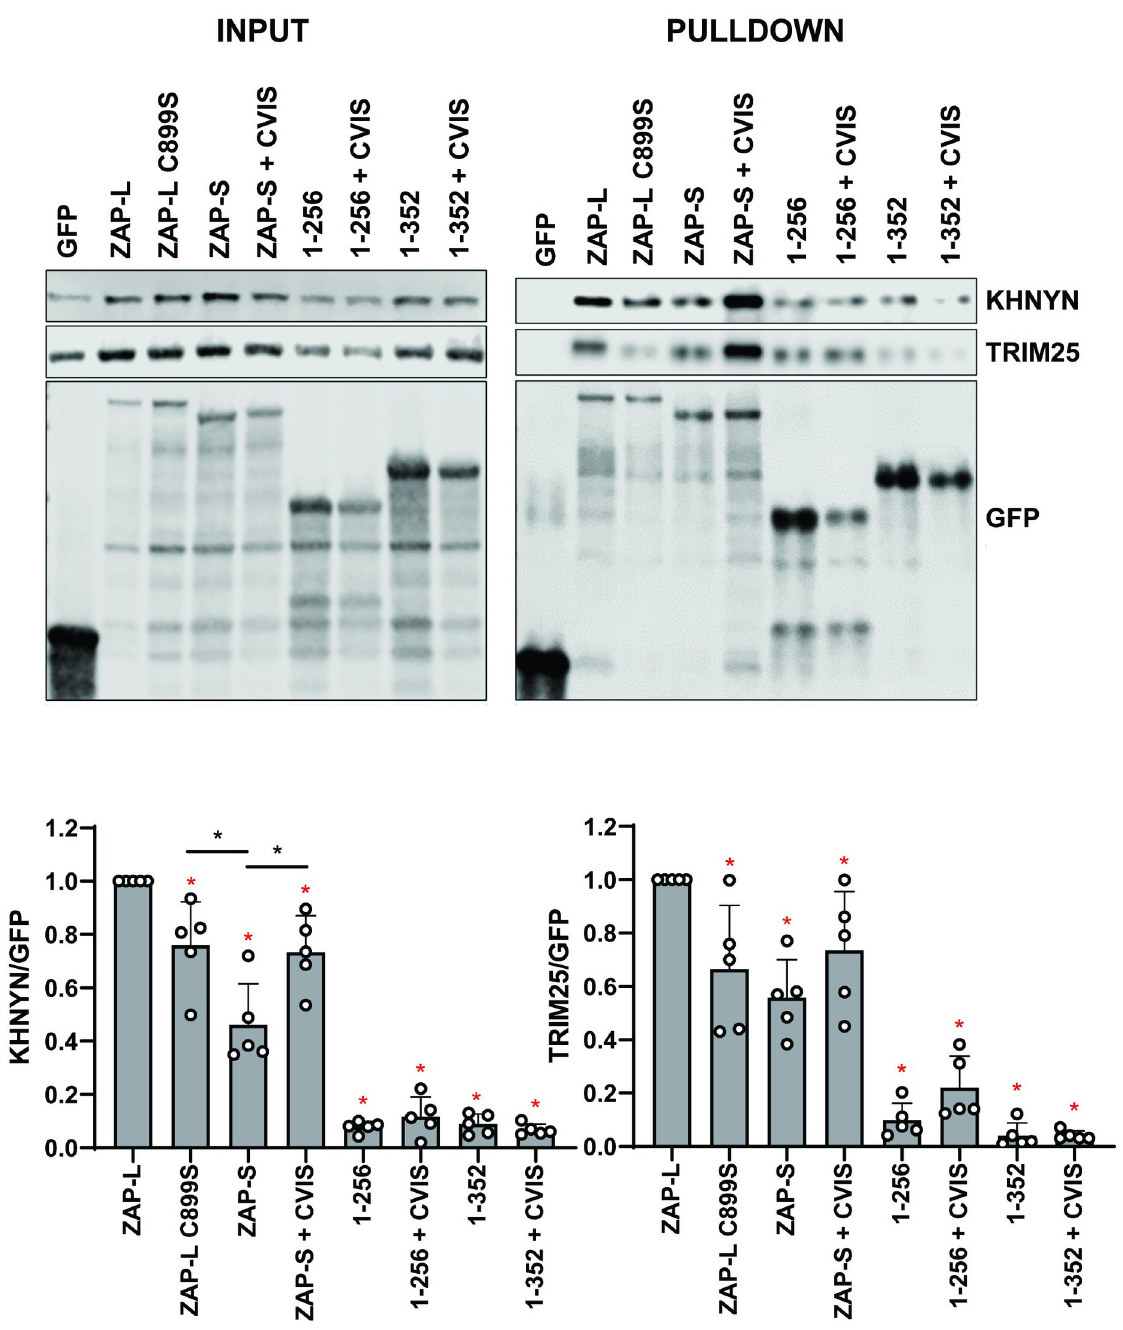
Fig 5. ZAP cofactors KHNYN and TRIM25 bind most efficiently to wild type ZAP-L. Upper left panel: Representative western blot of GFP-ZAP isoforms and mutant proteins expressed in HEK293T ZAP KO cells. Upper right panel: GFP-ZAP, TRIM25 and KHNYN co- immunoprecipitated using GFP-binding magnetic beads. Input and pulldown samples were stained for GFP as well as endogenous KHNYN and TRIM25. Lower panels: quantification of KHNYN and TRIM25 co-immunoprecipitated with GFP-ZAP normalized to the relative GFP signal. Mean of n = 5 + SD. � p < 0.05 for the sample compared to ZAP-L. � p < 0.05 for the comparisons demarked by the